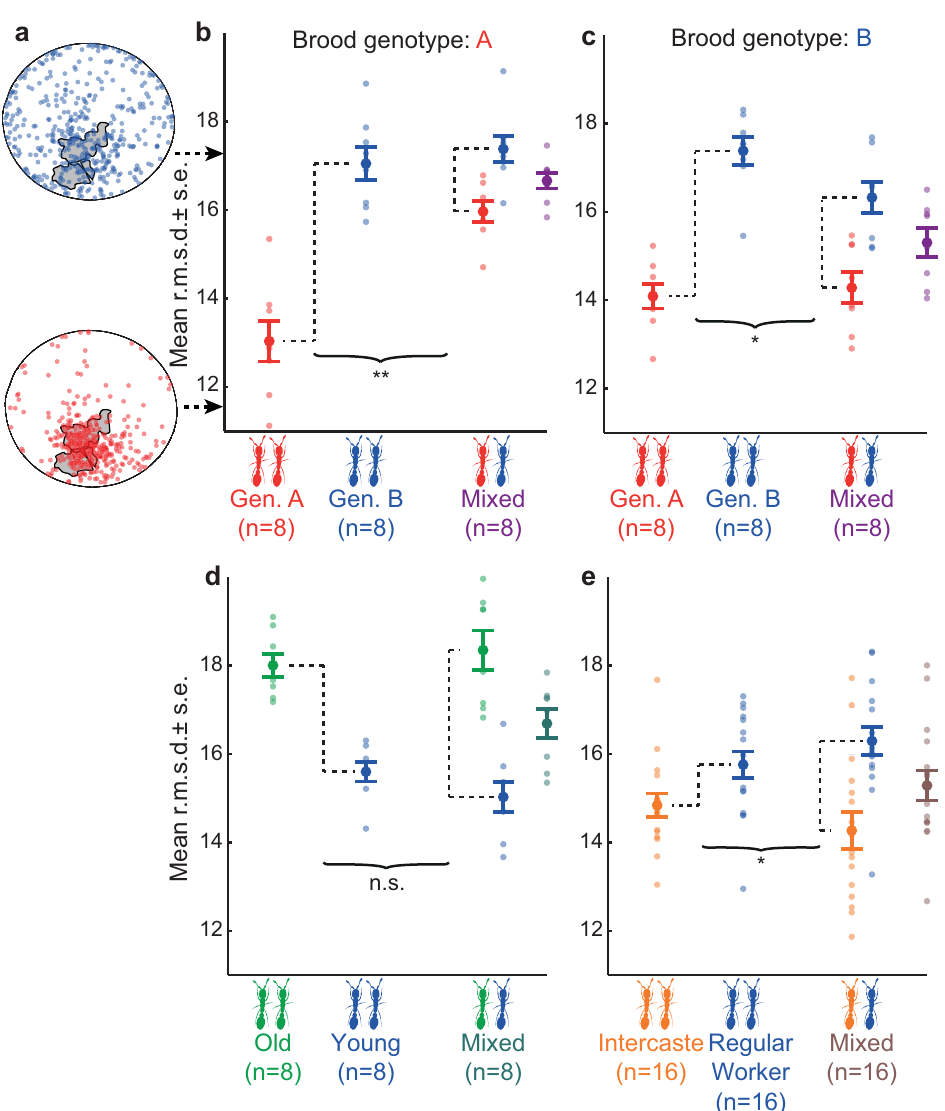
Fig 2. Behavior as a function of colony composition. ( a ) Spatial distributions of 2 ants with high (blue; genotype B) and low (red; genotype A) activity outside the nest. Arrows point to corresponding r.m.s.d. values. Gray areas represent the position of the larvae. ( b–e ) Mean behavior (mean r.m.s.d.) as a function of colony composition. Opaque circles represent mean behavior across individuals in replicate colonies or subcolonies. Solid circles represent average behavior across replicate colonies or subcolonies. For mixed colonies, data are shown both as type-specific and colony- level mean behavior (in “average” color). Sample sizes indicate the number of replicate colonies. Black curly brackets represent the effect of mixing on behavioral differences between types. ( b ) Behavioral convergence in genetically mixed colonies with A brood. B pure − A pure vs. B mixed − A mixed : t test: t = 3.86, p = 0.002. ( c ) Behavioral convergence in genetically mixed colonies with B brood. B pure − A pure vs. B mixed − A mixed : t = 2.63, p = 0.025. ( d ) No effect of mixing in demographically mixed colonies. Old pure − Young pure vs. Old mixed − Young mixed , t = − 1.50, p = 0.157. ( e ) Behavioral divergence in morphologically mixed colonies. Regular Worker pure − Intercaste pure vs. Regular Workers mixed − Intercaste mixed t = − 2.44, p = 0.022. n.s., nonsignificant; � , p < 0.05; �� , p < 0.01; ��� , p < 0.001. Raw data are available at doi.org/10.5061/dryad.hx3ffbgdd. r.m.s.d., root–mean–square